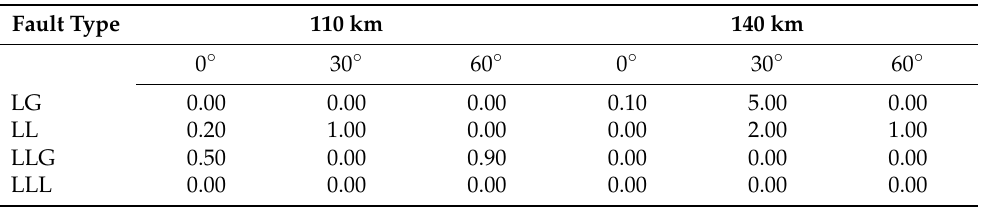
Table 13. AE at 110 and 140 km with a 20 Ω fault impedance.